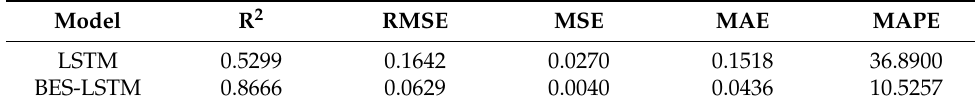
Figure 13. LSTM model prediction results. Table 11. Evaluation of LSTM model and BES–LSTM